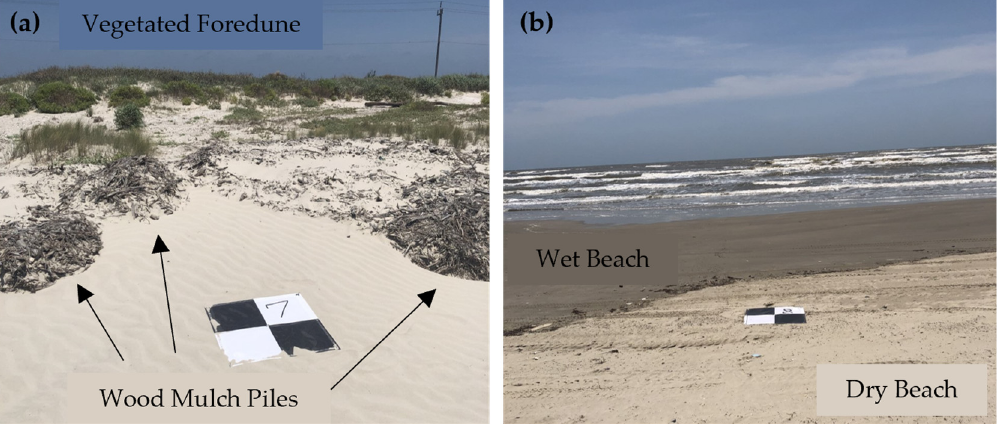
Figure 4. Follett’s Site 3 in May of 2022. ( a ) Ground control point 7 between wood chip piles in the foreground with a vegetated dune field in the background. The county road CR257 is visually blocked but sits immediately behind the vegetated foredunes; ( b ) Ground control point 8 near the water line.